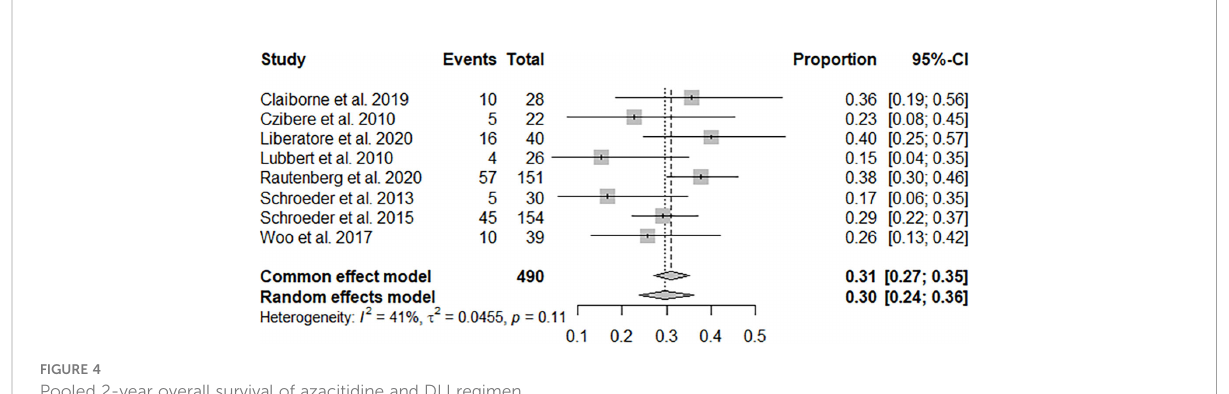
FIGURE 4 Pooled 2-year overall survival of azacitidine and DLI